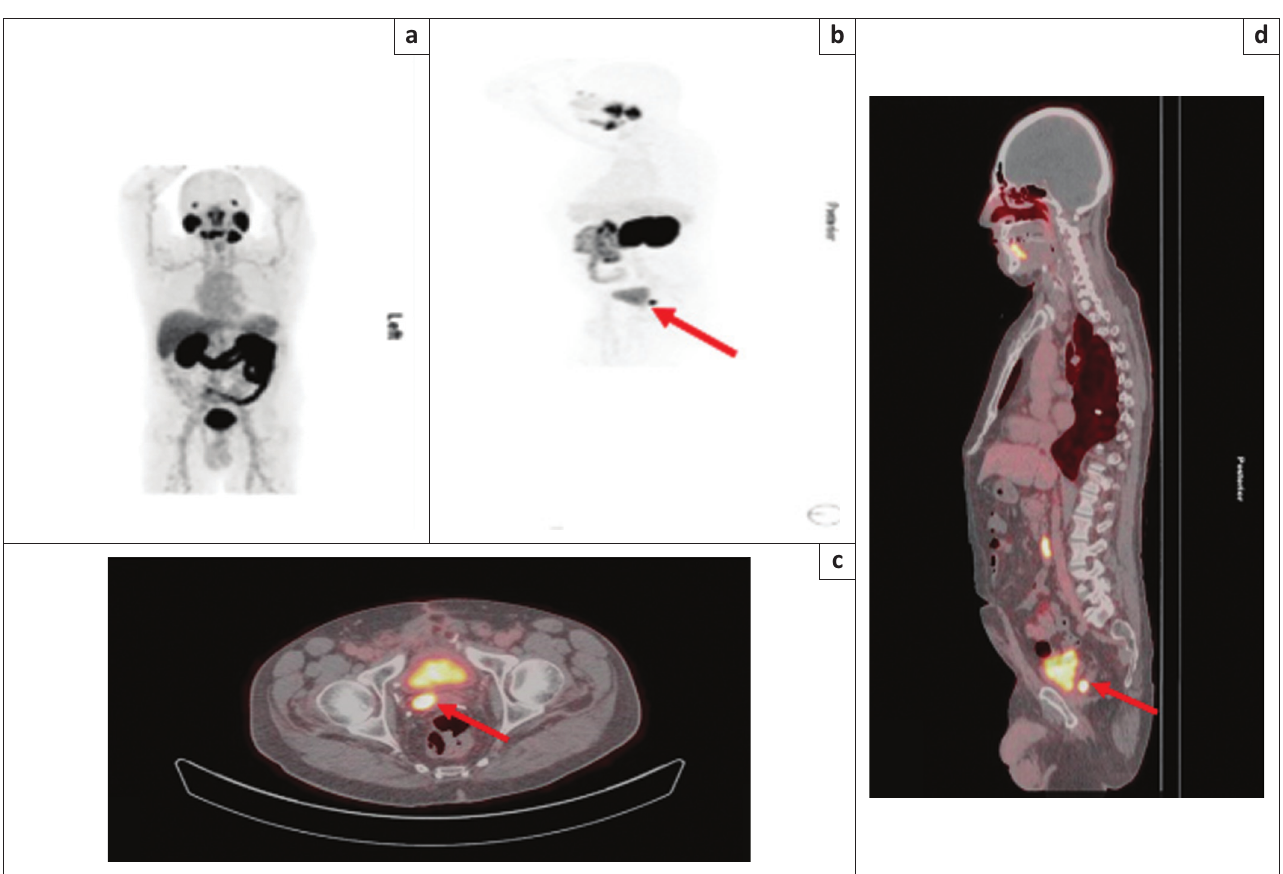
FIGURE 1: 68 Ga-PSMA PET and CT showing (a), MIP image with normal bio-distribution of tracer in lacrimal and salivary glands, proximal small bowel, kidneys, bladder; (b), Sagittal MIP with focal uptake in the right seminal vesicle; (c), Fused sagittal PET or CT image with similar uptake; (d), MIP, maximum intensity projection.